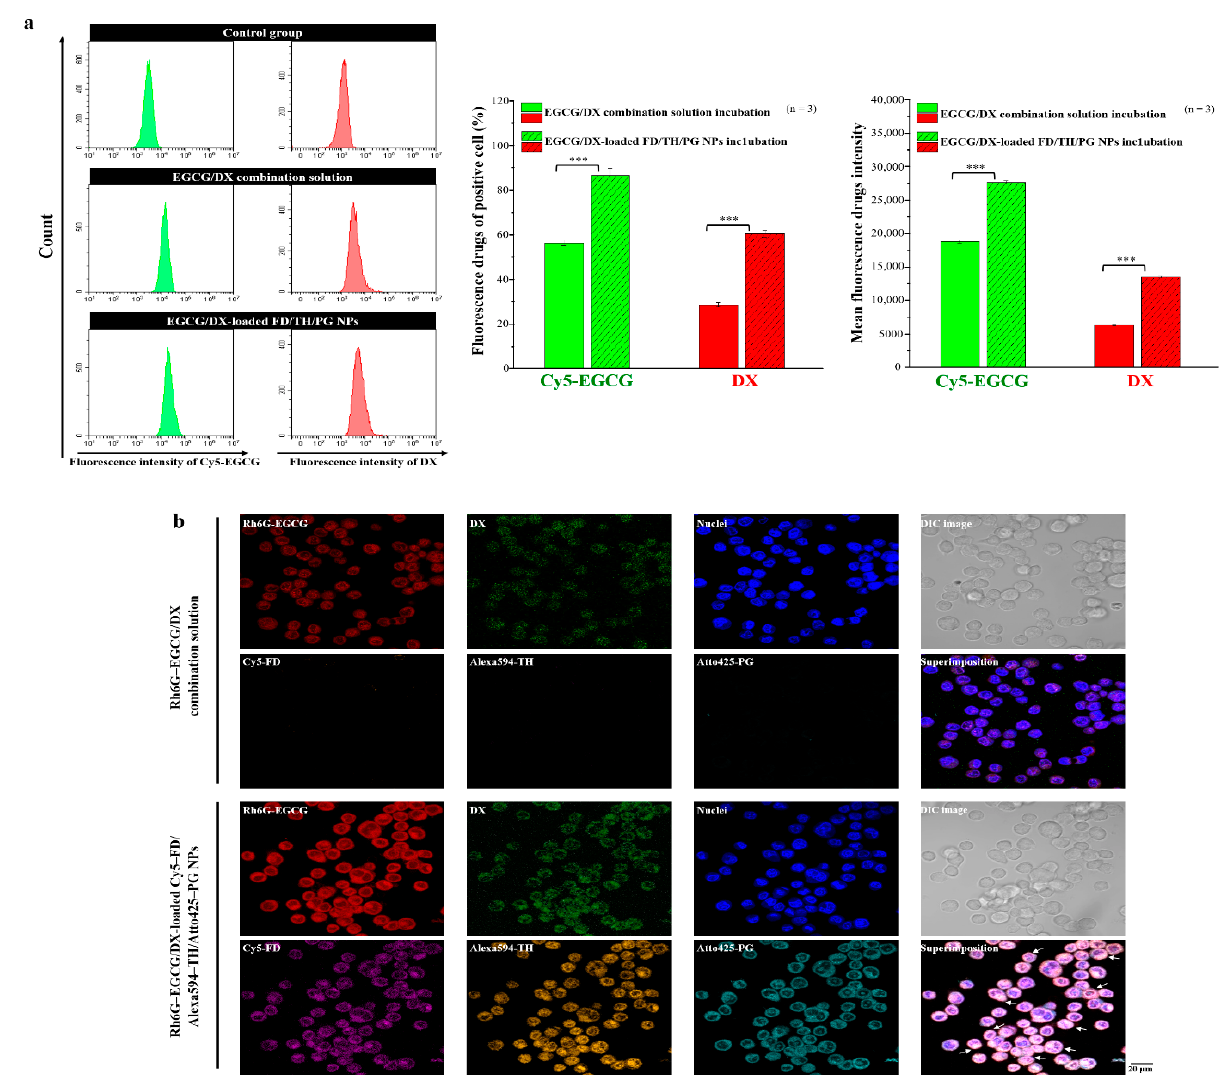
Figure 5. ( a ) In vitro cellular uptake of Cy5-GCG and DX was assessed using flow cytometry after treatment with EGCG/DX combination solution and EGCG/DX-loaded NPs; ( b ) Confocal images of gastric cancer cells viewing cellular distribution of the Rh6G-EGCG/DX combination solution and Rh6G-EGCG/DX-loaded Cy5-FD/Alexa594-TH/Atto425-PG NPs, *** represent statistically significant differences with p value <